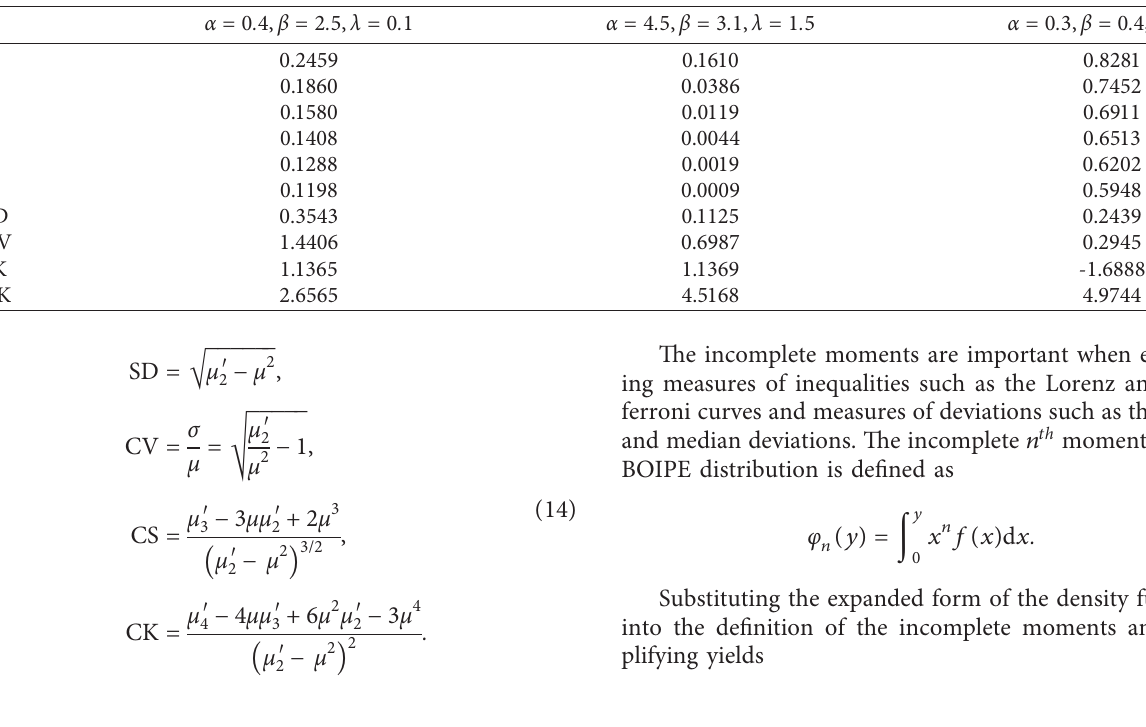
Figure 3: Histograms of simulated data from BOIPE distribution. Table 1: First six moments, SD, CV, CS, and